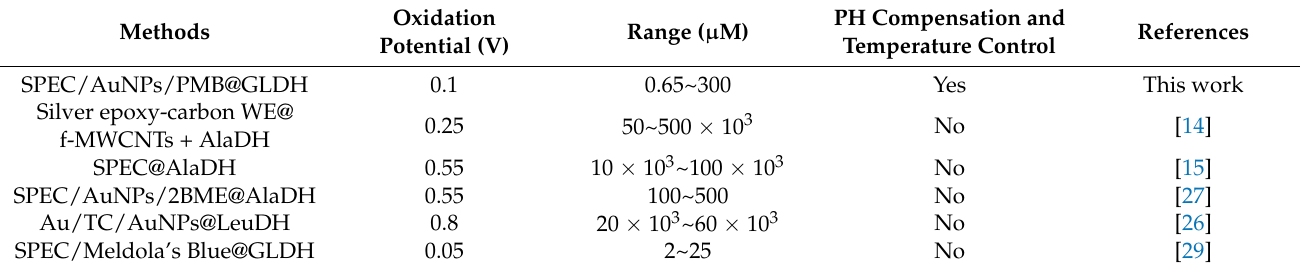
Table 3. Comparison of biosensor with previously reported ammonium sensors based on